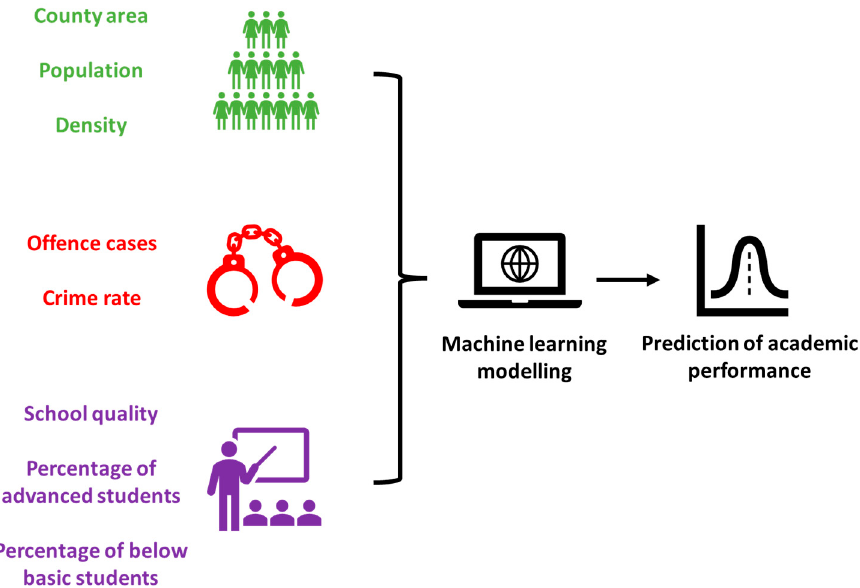
Figure 1. Framework of this study shows how ML used big data to predict academic performance.